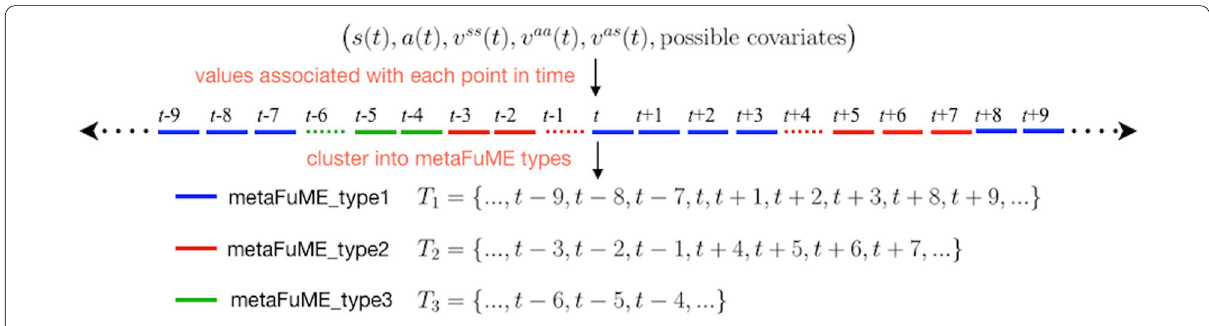
Fig. 2 Parsing the walk W into a set of metaFuMEs. Associated with each point t is a set of running values s ( t ) , a ( t ) , v ss ( t ) , v aa ( t ) , v as ( t ) , other possible covariates . Cluster analysis may be used to generate metaFuME categories. For purposes of illustration, we depict three types of metaFuMEs with associated lists of time steps—i.e., metaFuME sequence index sets—that can then be used to define the ensemble of values associated with each metaFuME type: blue = T 1 , red = T 2 , and green = T 3 . Note that we expect transition points between strings of metaFuMEs of one type (broken line segments), such as t − 6 , t − 1 and t + 4 , could well be outliers in the clustering process. Outliers may be assigned to the cluster to which they are closest in some suitably defined sense (as indicated by the colors of the broken